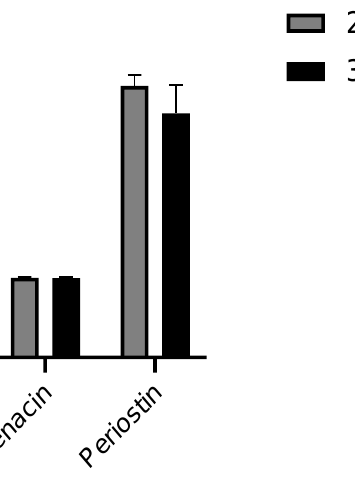
Figure 8. Percentage change in healthy fibroblast (MRC-5) ECM protein deposition when treated with 2FN or 3FN. Data are displayed as mean ± SD, n = 3, ** p < 0.01.